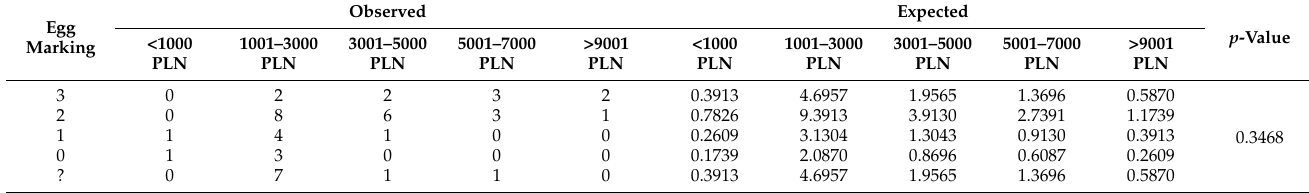
Table 4. The egg marking choices according to the indicative net income (PLN) of the respondents.